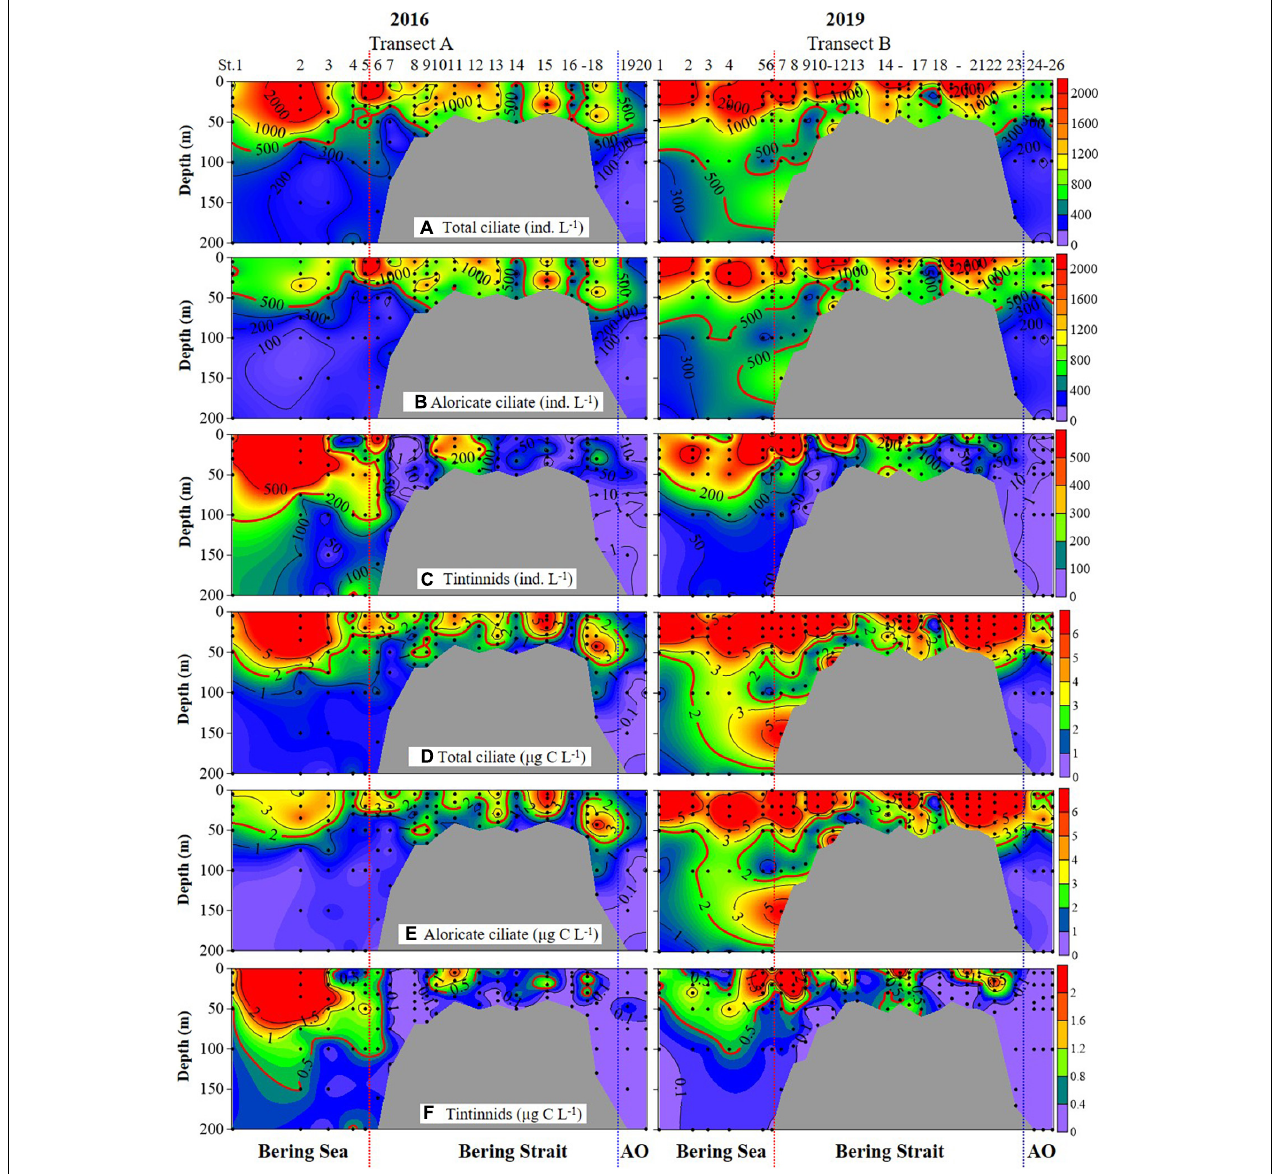
FIGURE 3 | Vertical distribution of total ciliate, aloricate ciliate, and tintinnid abundance (A–C) and biomass (D–F) from surface to bottom (or 200 m). Black dots, sampling depths; red dotted line, boundary between the Bering Sea and Bering Strait; blue dotted line, boundary between the Bering Strait and Arctic Ocean